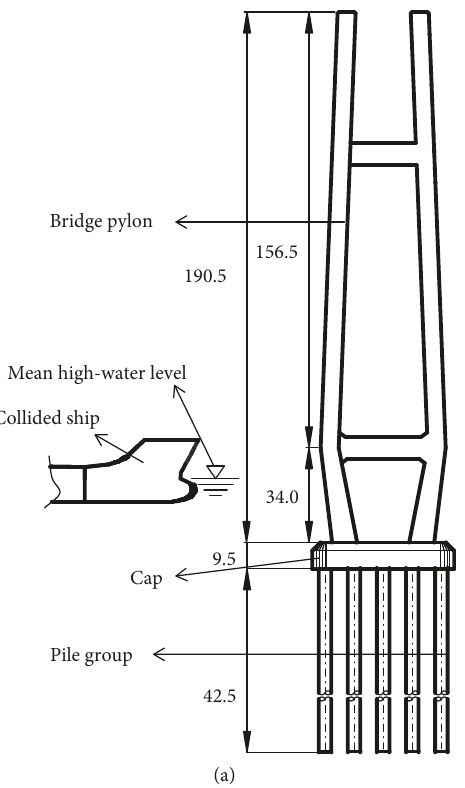
Figure 1: Bridge pylon structure. (a) Bridge pylon configuration. (b) FE model of bridge pylon.